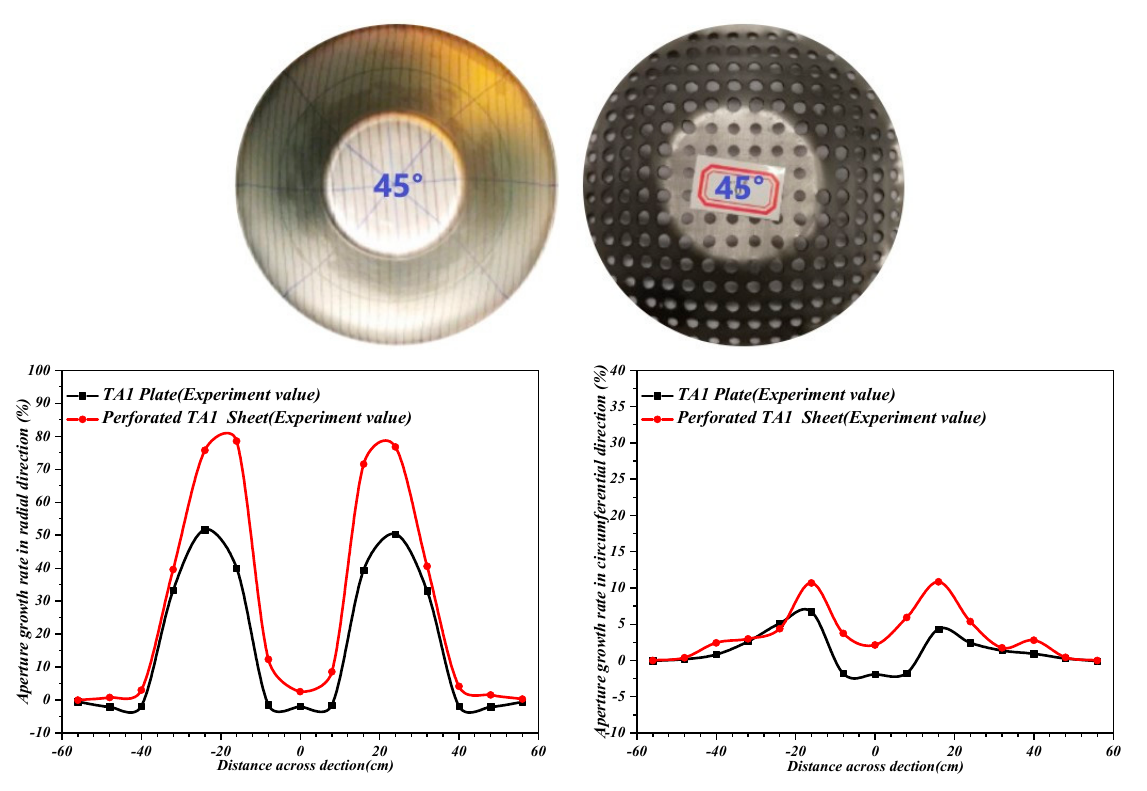
Figure 9. Curve of radial and circumferential aperture growth rate of titanium plate and perforated titanium sheet along the X axis.